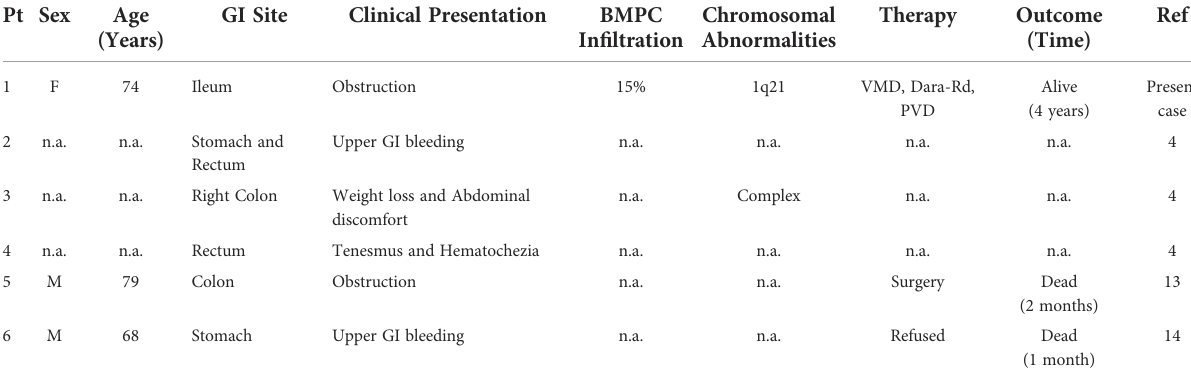
TABLE 2 Case reports of PCM with gastrointestinal tract involvement at